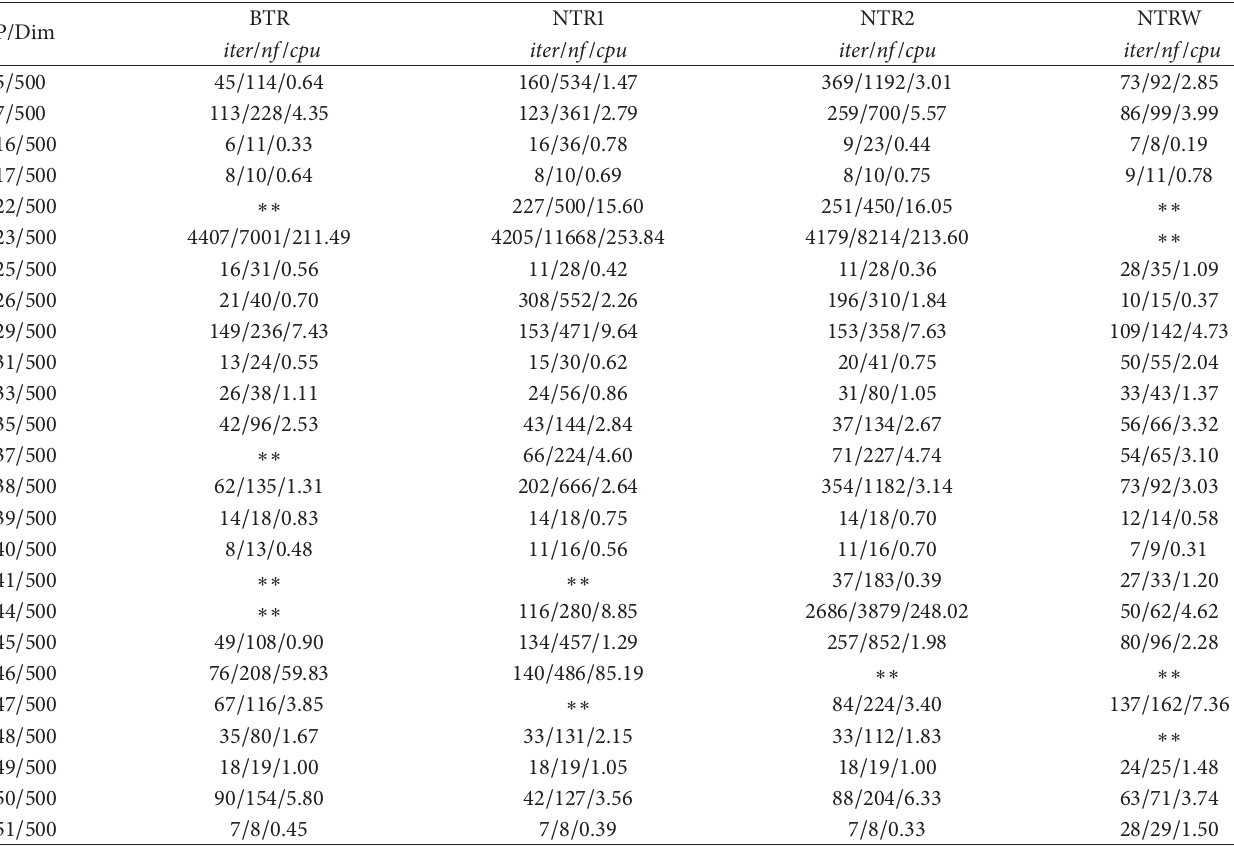
Table 3: Numerical comparisons for some middle-scale test problems.